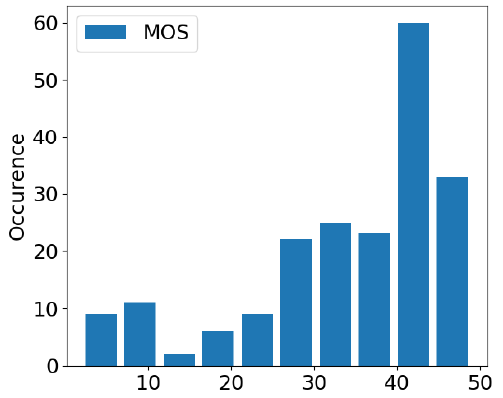
Figure 5. MOS distribution histogram.